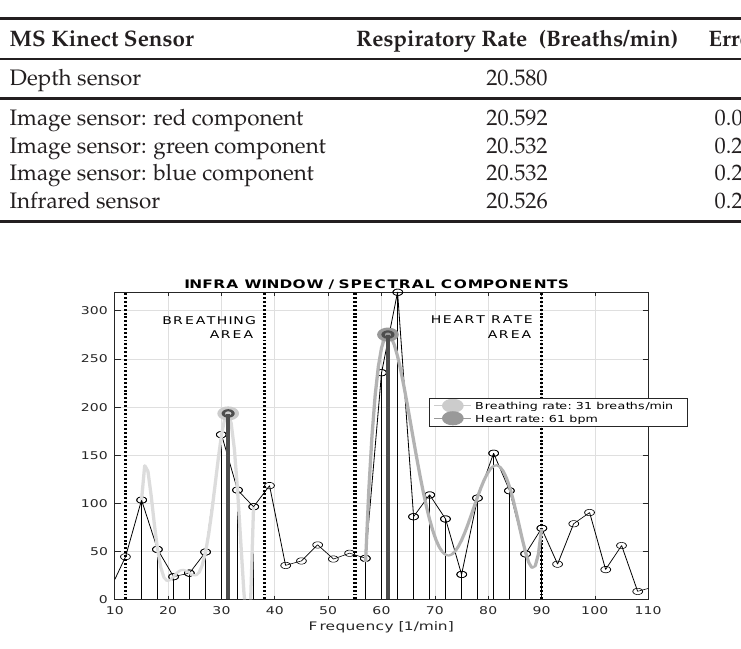
Figure 3. Time evolution of mean data values in selected frames with their spectra of ( a ) the red, green and blue components acquired by the image sensor; ( b ) the depth sensor data evolution with its spectrum; and ( c ) the infrared data detecting both the breathing frequency and the heart rate during a 120 s data segment. Table 1. Estimates of the respiratory frequency evaluated by Microsoft (MS) Kinect sensors in given regions of interest over a period of 120 s in stable conditions.